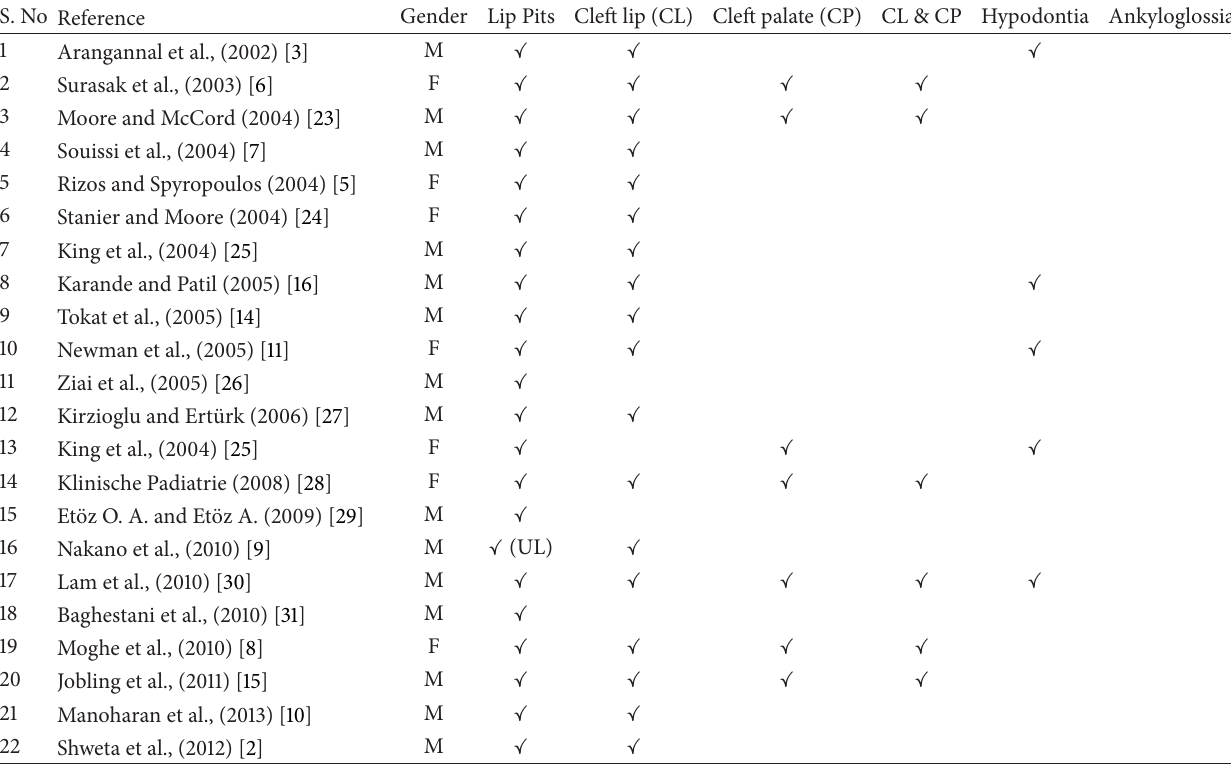
Table 1: Summary of the presence of lip pits, cleft lip and/or palate, hypodontia, and ankyloglossia in Van der Woude syndrome patients presented in the respective literature.